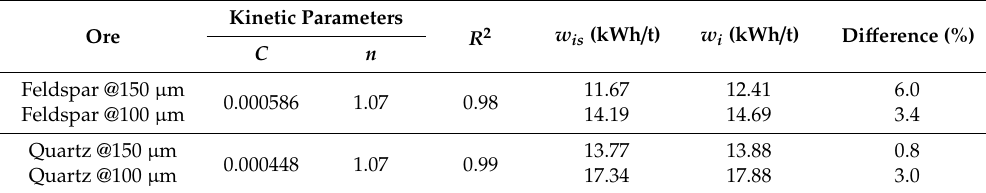
Table 3. Work Indexes for feldspar and quartz (reference sizes 100 and 150 µ m) obtained through the standard test and the simulation ( w i = Work Index; w is = simulated Work Index).